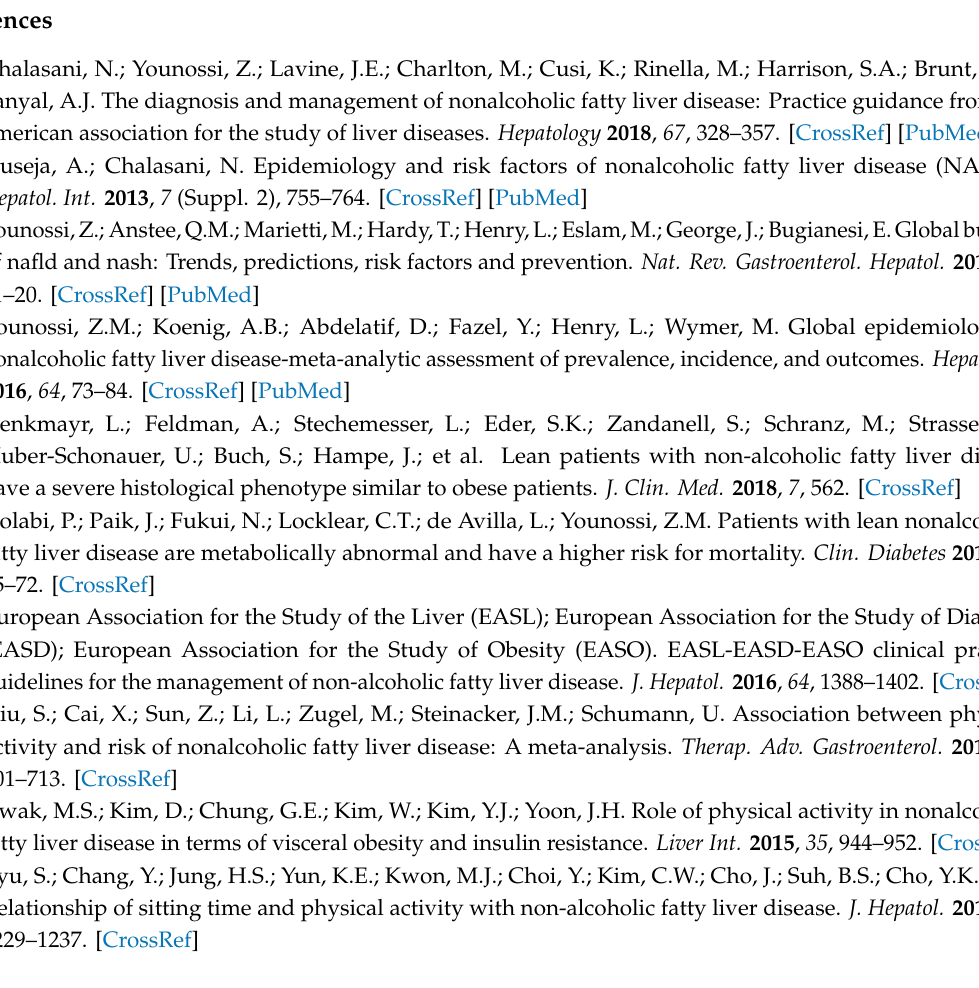
Table S1: Sociodemographic, lifestyle, and clinical correlates for NAFLD, Table S2: Sociodemographic, lifestyle, and clinical correlates for lean NAFLD, Table S3: Sociodemographic, lifestyle, and clinical correlates for abnormal levels of ALT among participants with NAFLD, Table S4: Sociodemographic, lifestyle, and clinical correlates for abnormal levels of AST among participants with